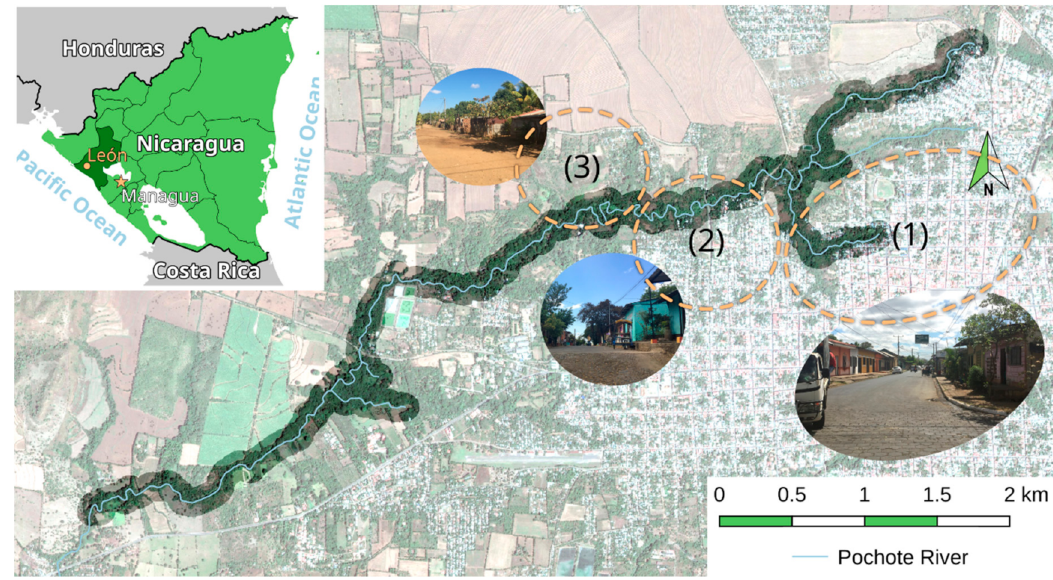
Figure 1. Overview of study area: Pochote River and City of Le ó n with di ff erent settlement structures: (1) formal and densely urbanized, (2) informal urban-rural transitional and (3) formal rural